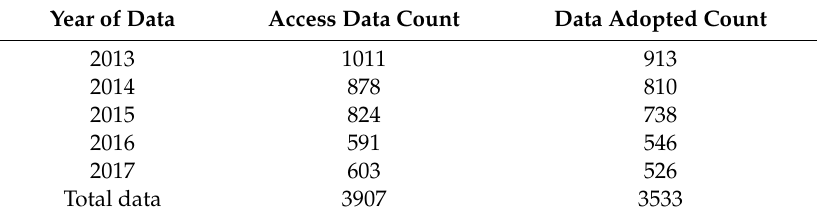
Table 1. Yearly data for spatial autocorrelation